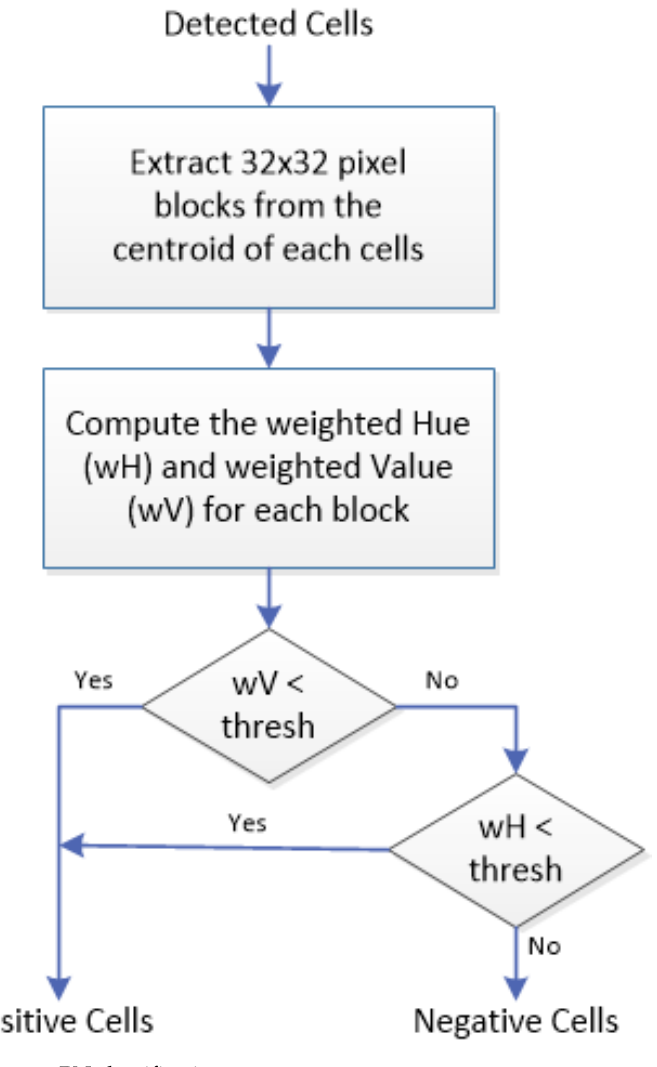
Figure 3. PN classification